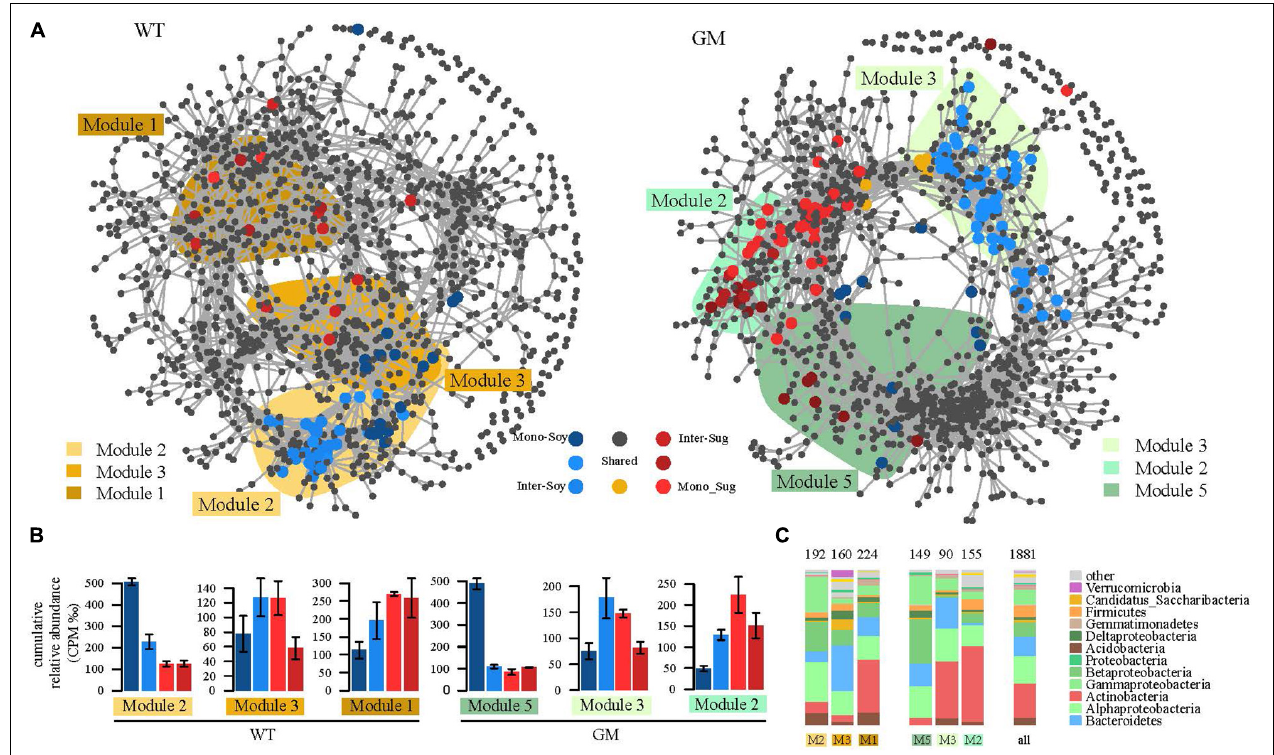
FIGURE 6 | (A) Microbial symbiosis of transgenic and wild-type sugarcane root system under different Yuan intercropping combinations. The co-occurrence network visualized the correlation between operational taxa (OTUs) ( ρ > 0.7, p < 0.001). These colored dots represent OTUs belonging to different planting patterns. Gray dots indicate insensitivity to experimental treatment. The shaded area represents the network module that contains the OTU for each response. (B) Cumulative relative abundance (as counts per million, CPM; y-axis in × 1,000) of all bacteria of the cropping sensitive modules in networks. The cumulative relative abundance in samples of Inter_Soybean (light blue), Mono_Soybean (dark blue), Inter_Sugercane (dark red), Mono_Sugarcane (light red) cropping systems indicates the overall response of cropping sensitive modules to the different patterns. (C) The composition of the relative abundance at the class level in each module is compared with the overall taxonomic distribution of the entire dataset (the “ALL” column).